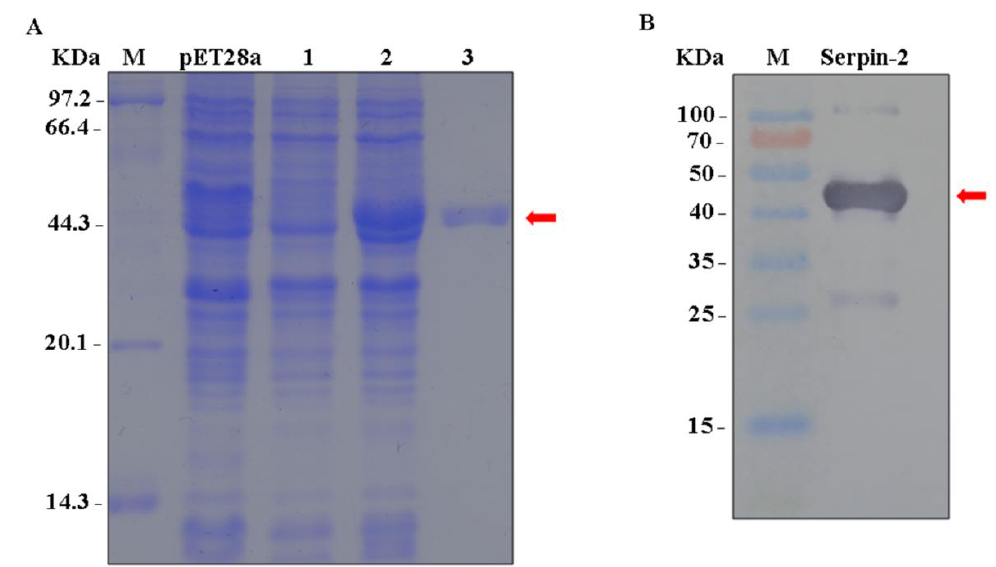
Figure 5. ( A ) Analysis of recombinant Bmserpin2 protein SDS-PAGE. M: molecular weight markers. pET-28a used as a control. Lane 1: Negative control without induction. Lane 2: Induced expression under isopropyl β -D-thiogalactoside (IPTG). Lane 3: Purified recombinant Bmserpin2 protein. ( B ) Western blot analysis of recombinant Bmserpin2 using anti-His antibody.